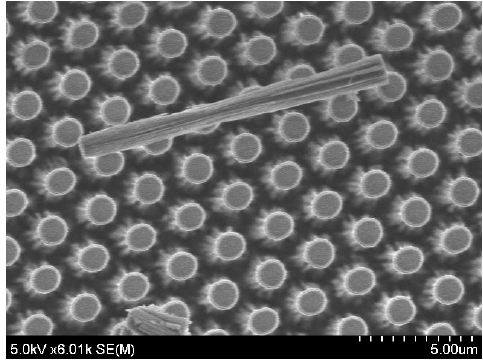
Figure 9. Pillars after 60-min etching process.